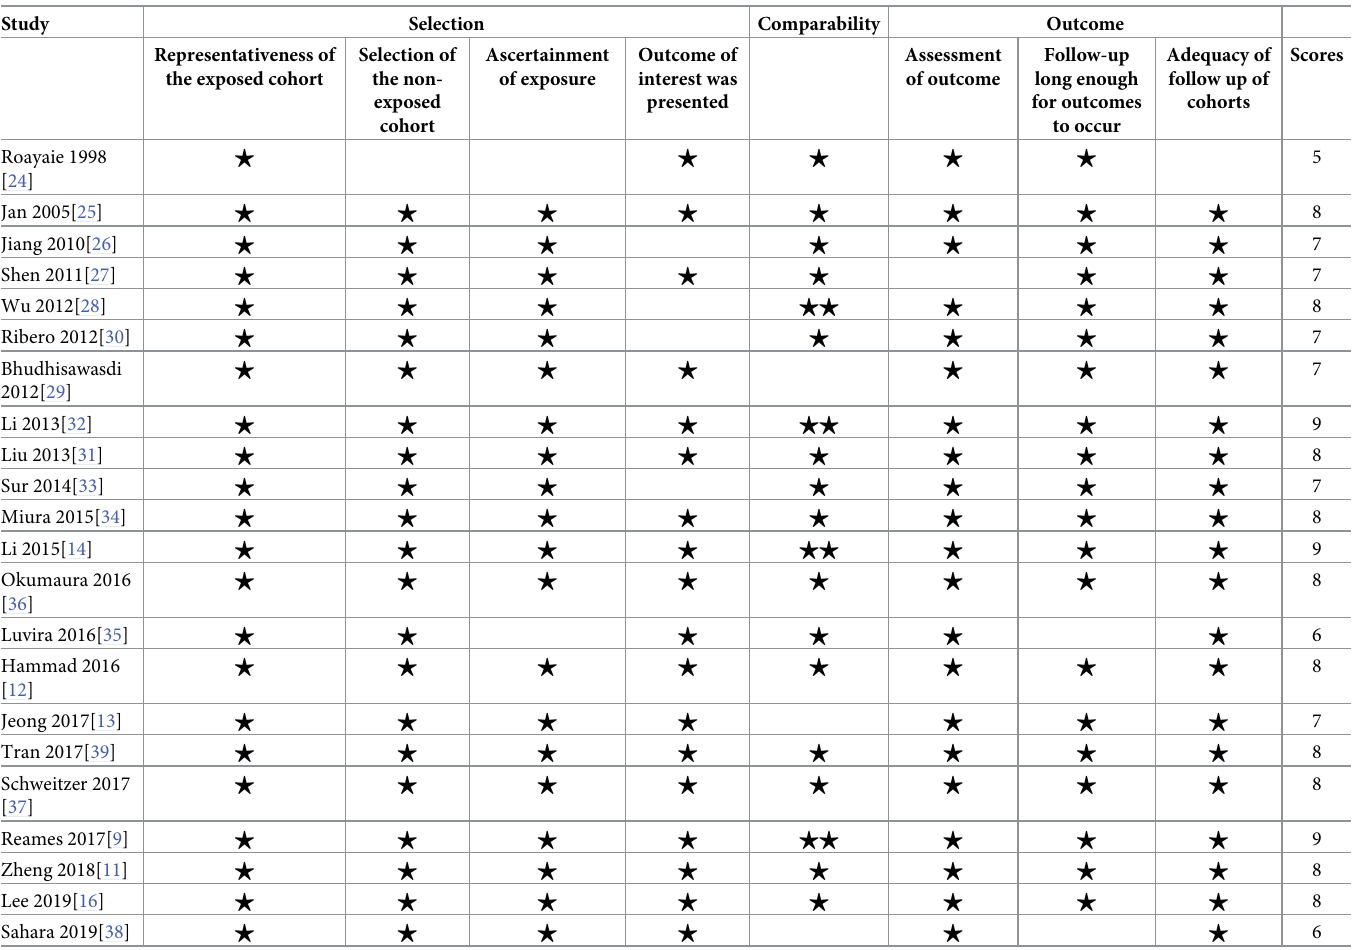
Table 3. Newcastle-Ottawa quality assessment of the included